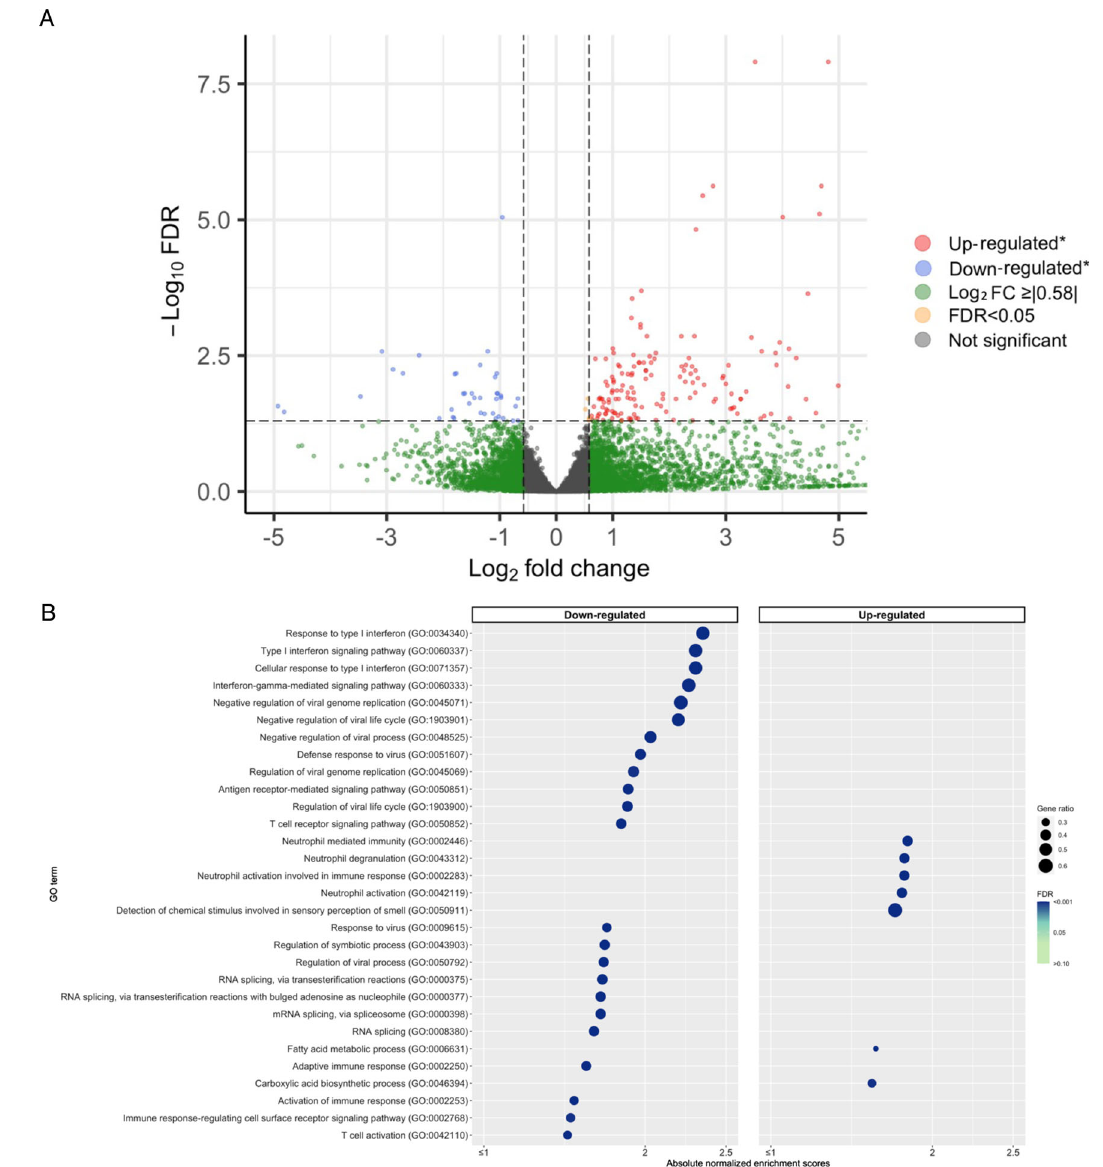
Fig. 2 | Differential gene expression analysis of host transcriptome data with regard to the use of positive pressure ventilation in infants hospitalized for bronchiolitis. A Volcano plot of differentially expressed genes (transcriptome). Thethresholdoflog2foldchangeis|0.58|(i.e., ≥ |1.5|-foldchange),andthatofFDRis <0.05. There were 197 differentially expressed transcripts that met these criteria. B Genesetenrichmentanalysis(transcriptome).Weshowed30hostpathways(GO